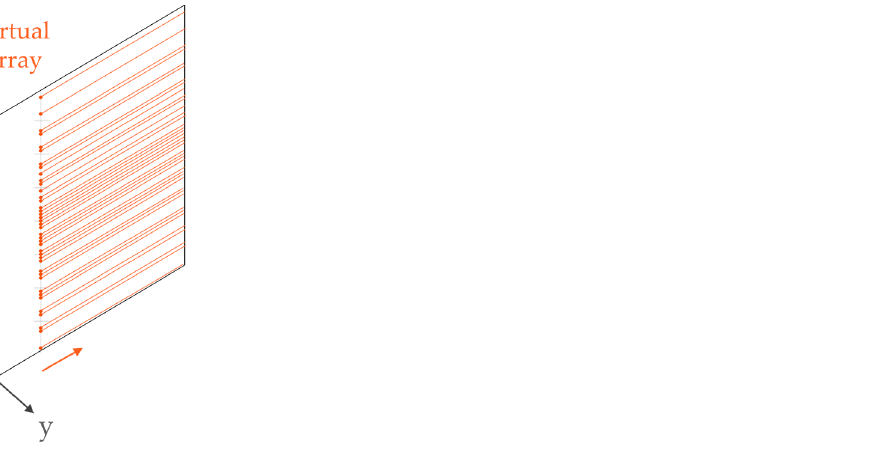
Figure 6. Geometry of the three-dimensional focalization algorithm. 3. Results 3.1. Tests in Controlled Scenario We first performed measurements in a controlled scenario. A corner reflector with edges about 50 cm long was located in front of the radar at a distance of about 11 m, as shown in Figure 7. Figure 8 shows the resulting radar images obtained by acquisitions performed using the CS array (Figure 8a) and the non-uniform array (Figure 8b). These images are obtained by focusing the radar raw data on the y-z plane that intersects the